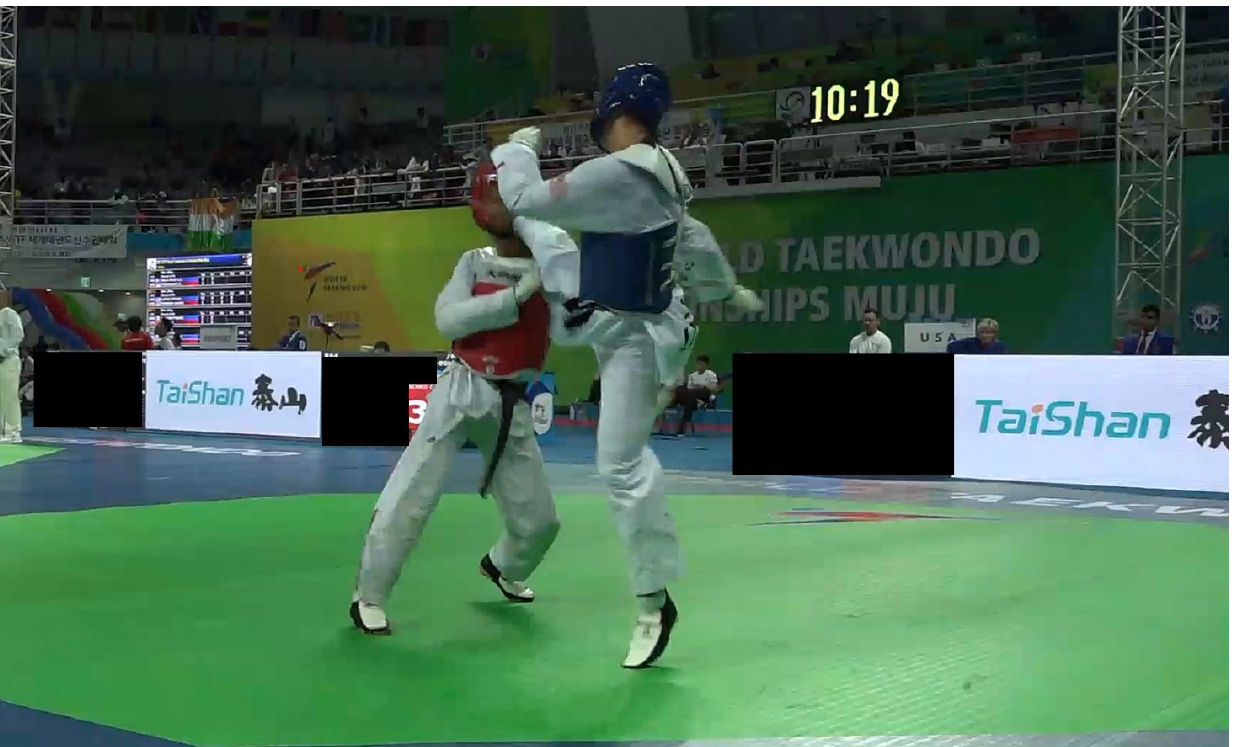
Figure 2. A case of head blow during Taekwondo sparring in this study.